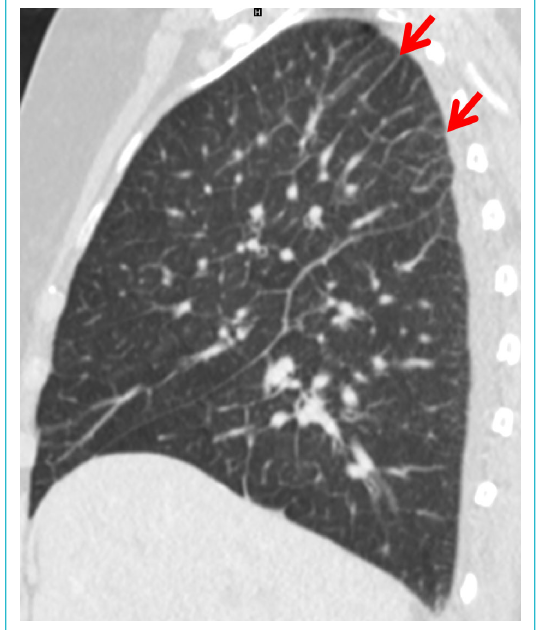
Figure 2: Predominantly apical Kerley B lines (red arrow) due to early pulmonary congestion in a 74-year-old male patient with car- diac